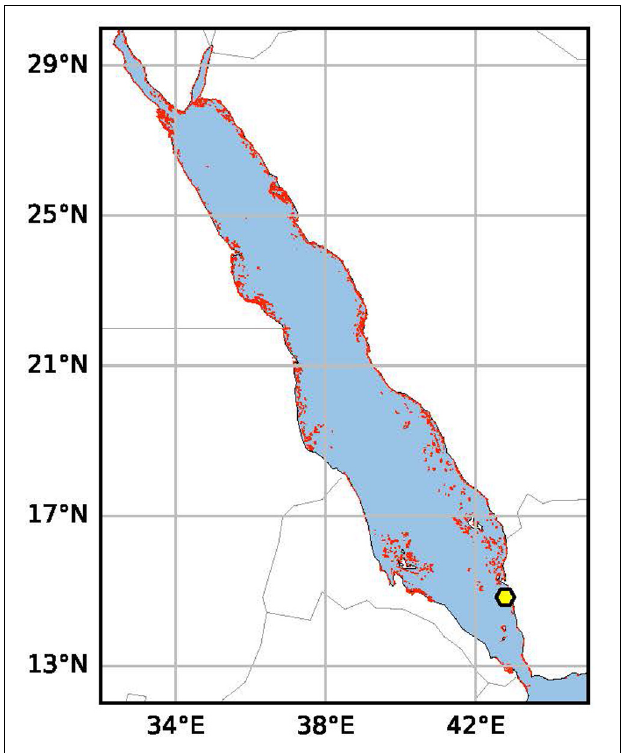
FIGURE 2 | Map of the Red Sea with reefs denoted in red and the Safer tanker’s location marked in yellow (UNEP-WCMC et al.,